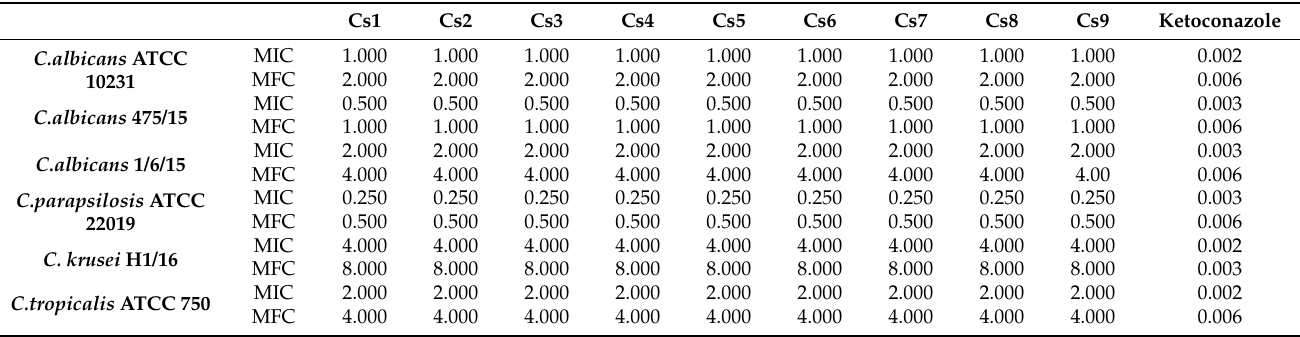
Table 6. Anticandidal activity of examined extracts, results are in